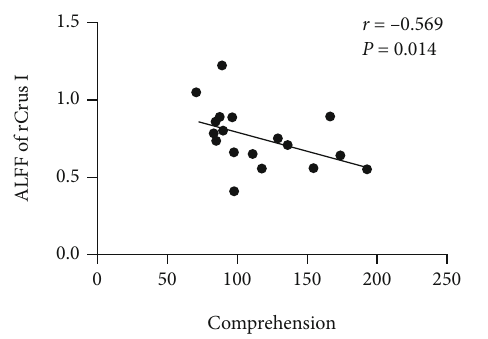
Figure 4: Correlation analysis between ALFF values of rCrus I and comprehension scores ( r = − 0 : 569 , p = 0 : 014 ).